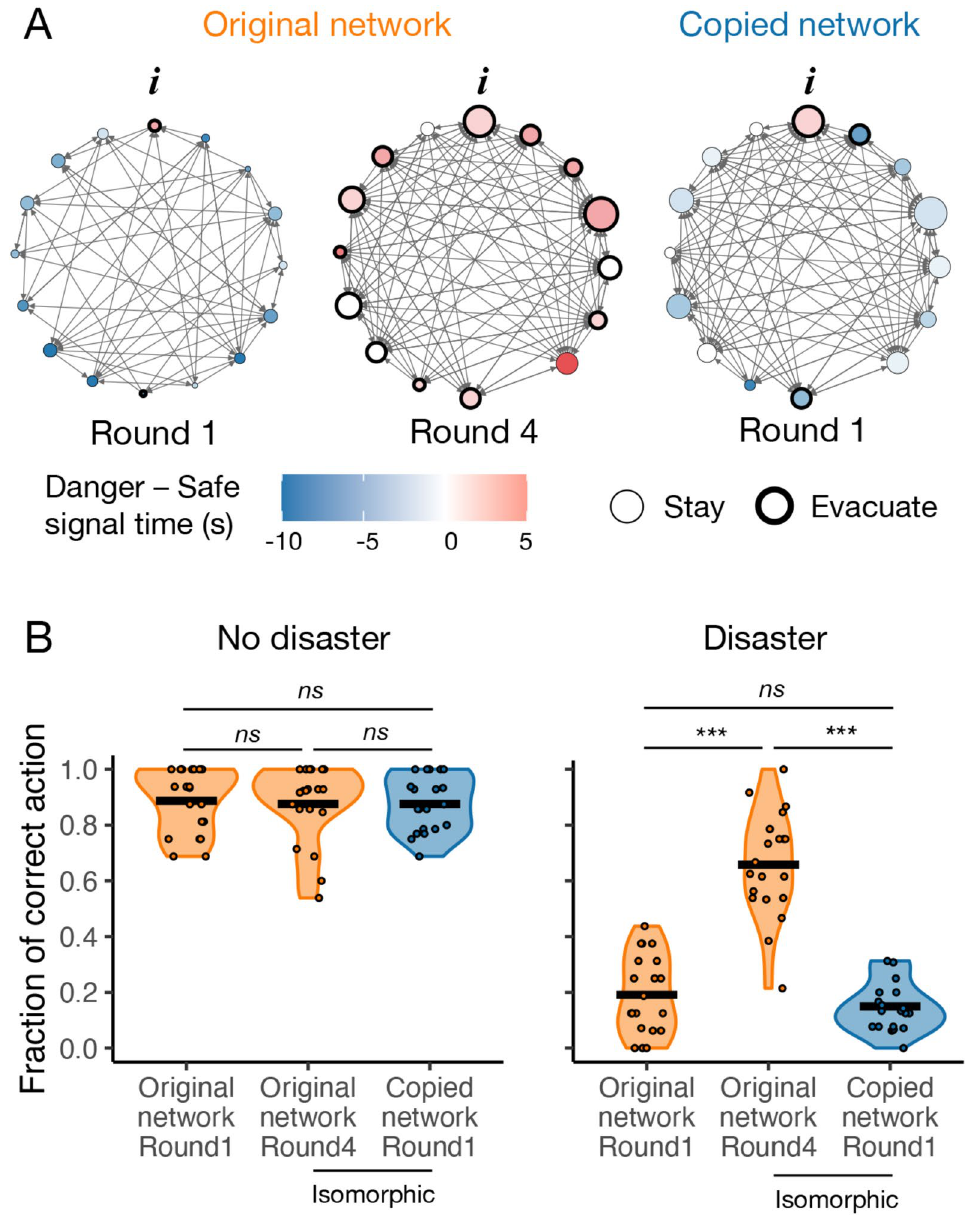
Figure 4. Isomorphic networks do not improve collective performance without individual experience. ( A ) The states at the first and final rounds in an example session of the dynamic network condition with always “disaster” occurrence, and the state at the first round with the isomorphic network of the original session at the final round. Node position fixes with individuals in the original session. Node size indicates in-degree (the number of connections pointing to the node; i.e., the number of people “listening” to the player). Node color indicates the signaling time of safe and danger signals. The bold outline frame indicates the subject’s evacuation. “i” indicates the node of an informed subject. ( B ) Behavioral accuracy in dynamic networks at the first and final rounds, compared with copied, isomorphic networks at the first round. Dots show results for each session, shadings show the distributions of them, and black crossbars show the averages ( n = 20). ns indicates P ≥ 0.05 and *** indicates P < 0.001 with t test. Without individual experience, network structure alone does not improve behavioral accuracy in the sessions with